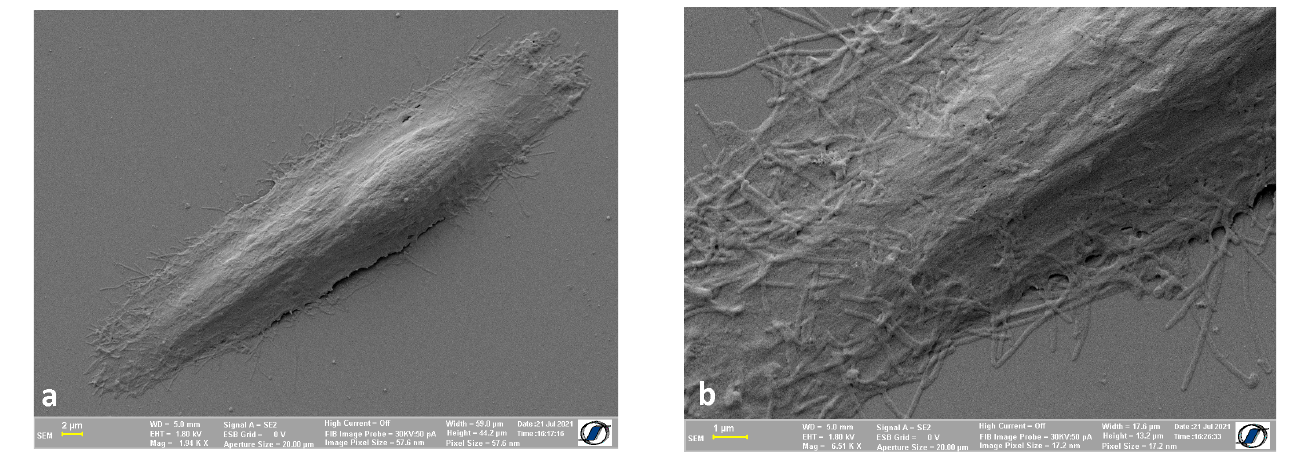
Figure 3. Human osteosarcoma cells—air dried: ( a ) the entire cell; ( b ) close-up of the cell membrane with all the details of it.